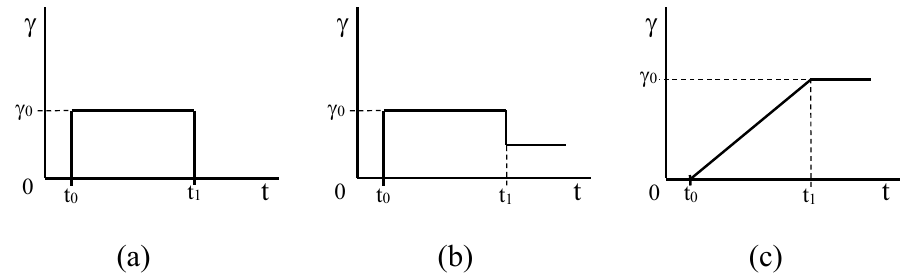
Figure 4: Curves of deformation ( 𝛾 ) versus time (t) under constant stress: (a) elastic response; (b) plastic response; (c) viscous response. The stress is applied at t=t 0 and removed at t=t 1 . Modified from [3,